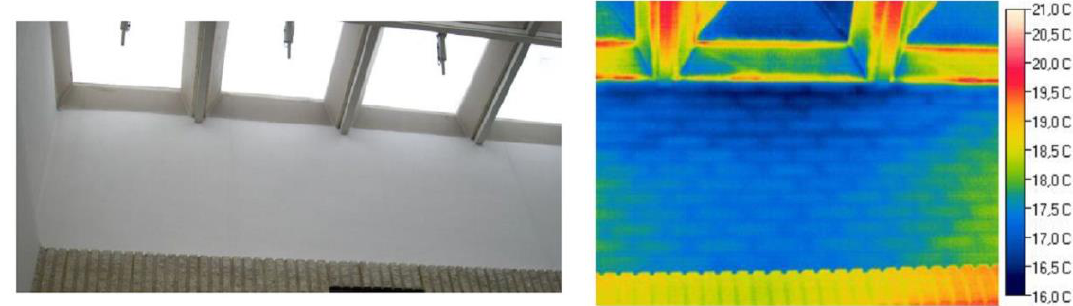
Figure 9. Indoor thermogram and RGB image of a skylight revealing air infiltration and thermal bridges.